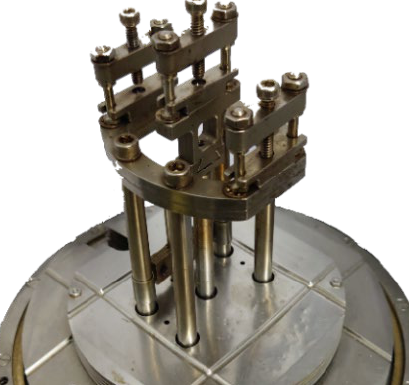
Table 2. Excitation frequency table for tensile mode DMA experiments.